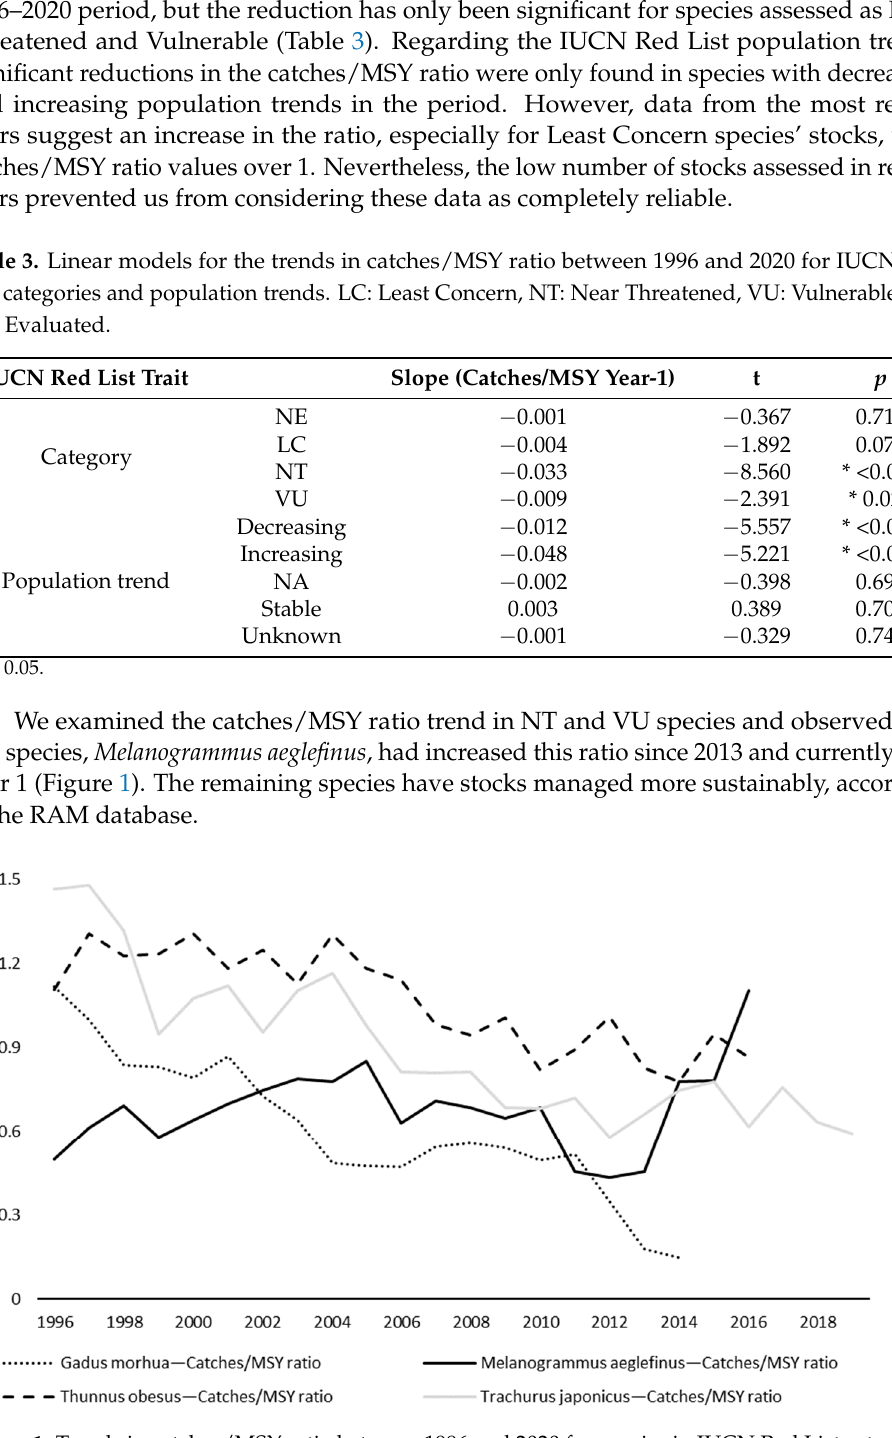
Figure 1. Trends in catches/MSY ratio between 1996 and 2020 for species in IUCN Red List categories NT (Near Threatened, grey line) and VU (Vulnerable, black lines).